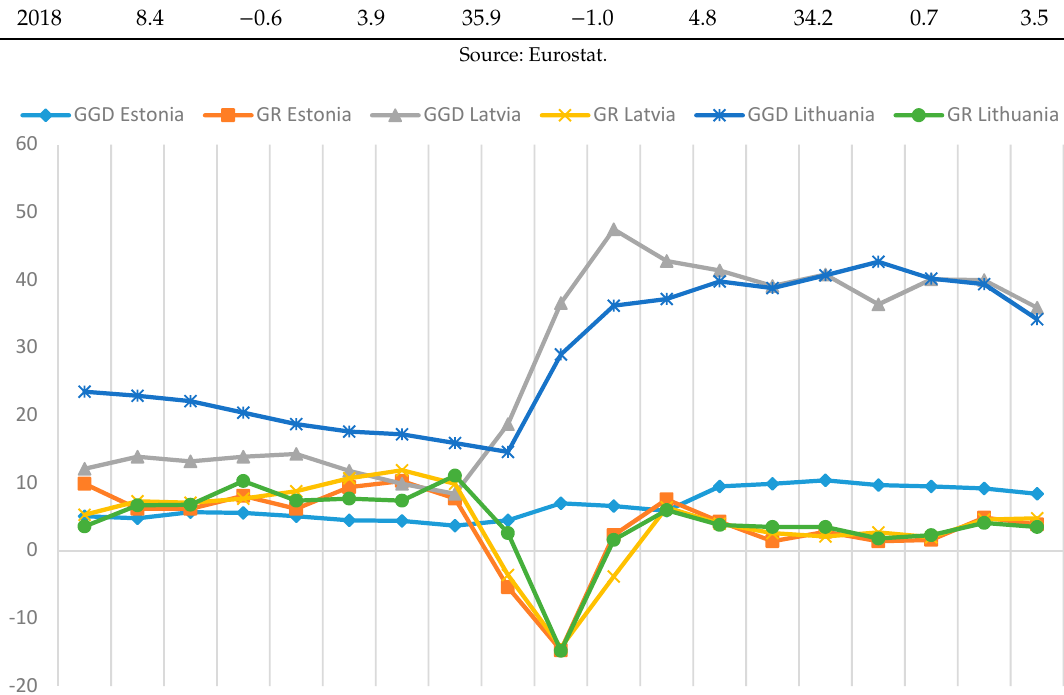
Figure 3. The Baltic countries’ GD percentage of GDP versus growth rate percentage change from previous year, 2000–2018; Source: Eurostat. 4.2. Central and Eastern European Countries In Central and Eastern European countries, a relatively safe level of GGD was recorded—with the exception of Hungary in 2005, which had more than the recommended 60% of its GDP in 2005 (Table 2). The Czech Republic recorded a low GGD (i.e., below 30% of GDP) in 2000–2008 while maintaining a moderately high growth rate between 2003 and 2007. The world financial crisis decreased the country’s growth rate to 4.8% in 2009, which most probably forced the GGD to rise to